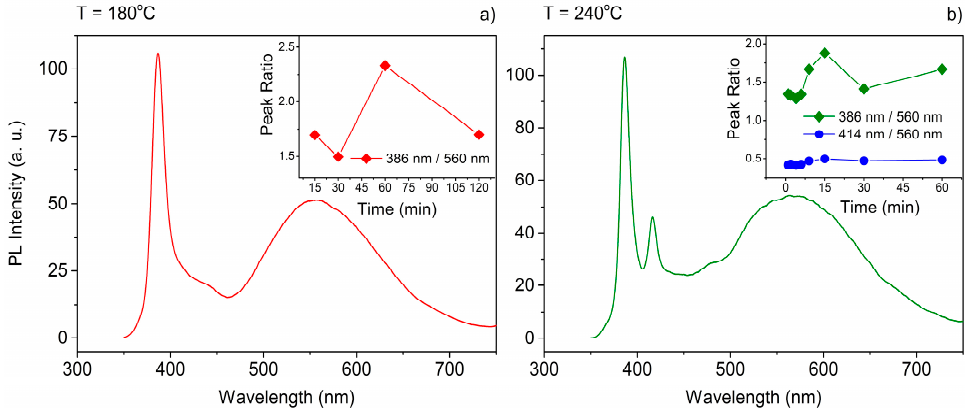
Figure 5. Photoluminescence spectra of CdS nanocrystals obtained with different reaction tempera- tures and fixed Zn(Ac) 2 concentration. The insets show the ratio of the peak intensity related with excitonic emission to the peak related with defects for those spectra. The reaction temperature is indicated on top of every graph: ( a ) 180 ◦ C; ( b ) 240 ◦ C. The Zn:Cd ratio for all samples was 4:4. TEM observations confirm the flat shape of obtained nanostructures (Figure